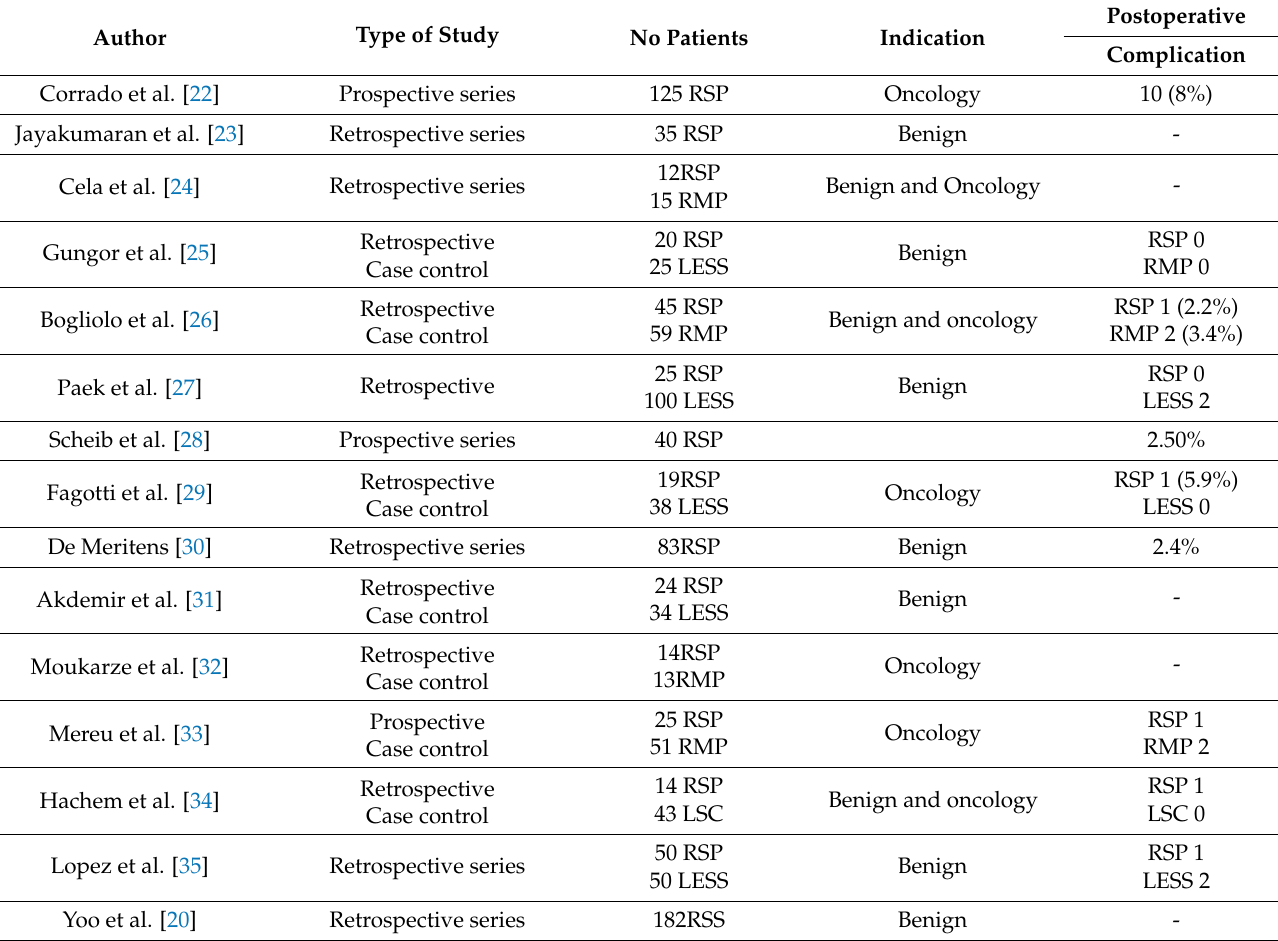
Table 2. Studies on R-LESS